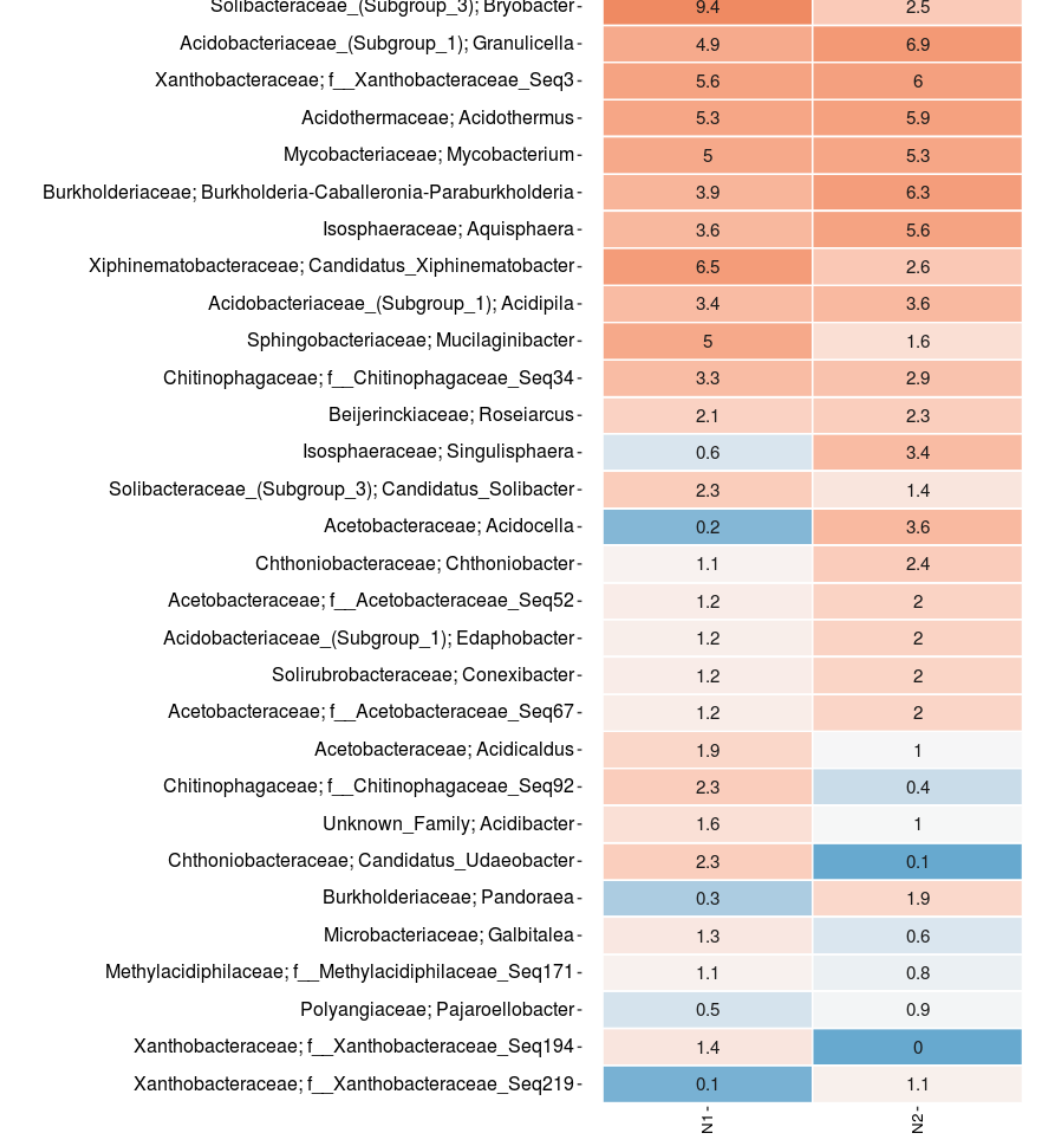
Figure 8: Heatmap of the 30 most abundant phylotypes for samples N1_R1 and